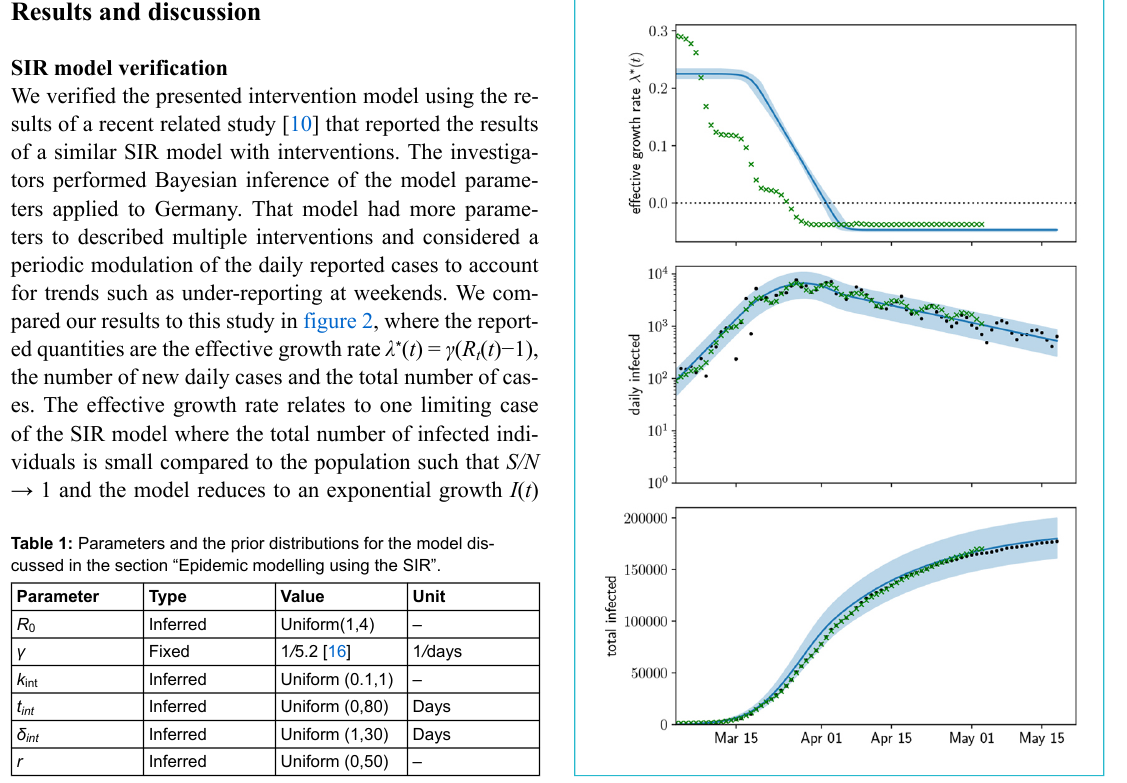
Figure 2: The effective growth rate (top), the number of new infec- tions per day (middle) and the total number of infections in Ger- many (bottom) fitted by present model (blue lines and shades) compared to median predictions from [10] (green crosses). The solid lines show the mean prediction and the shades are the 90% confidence